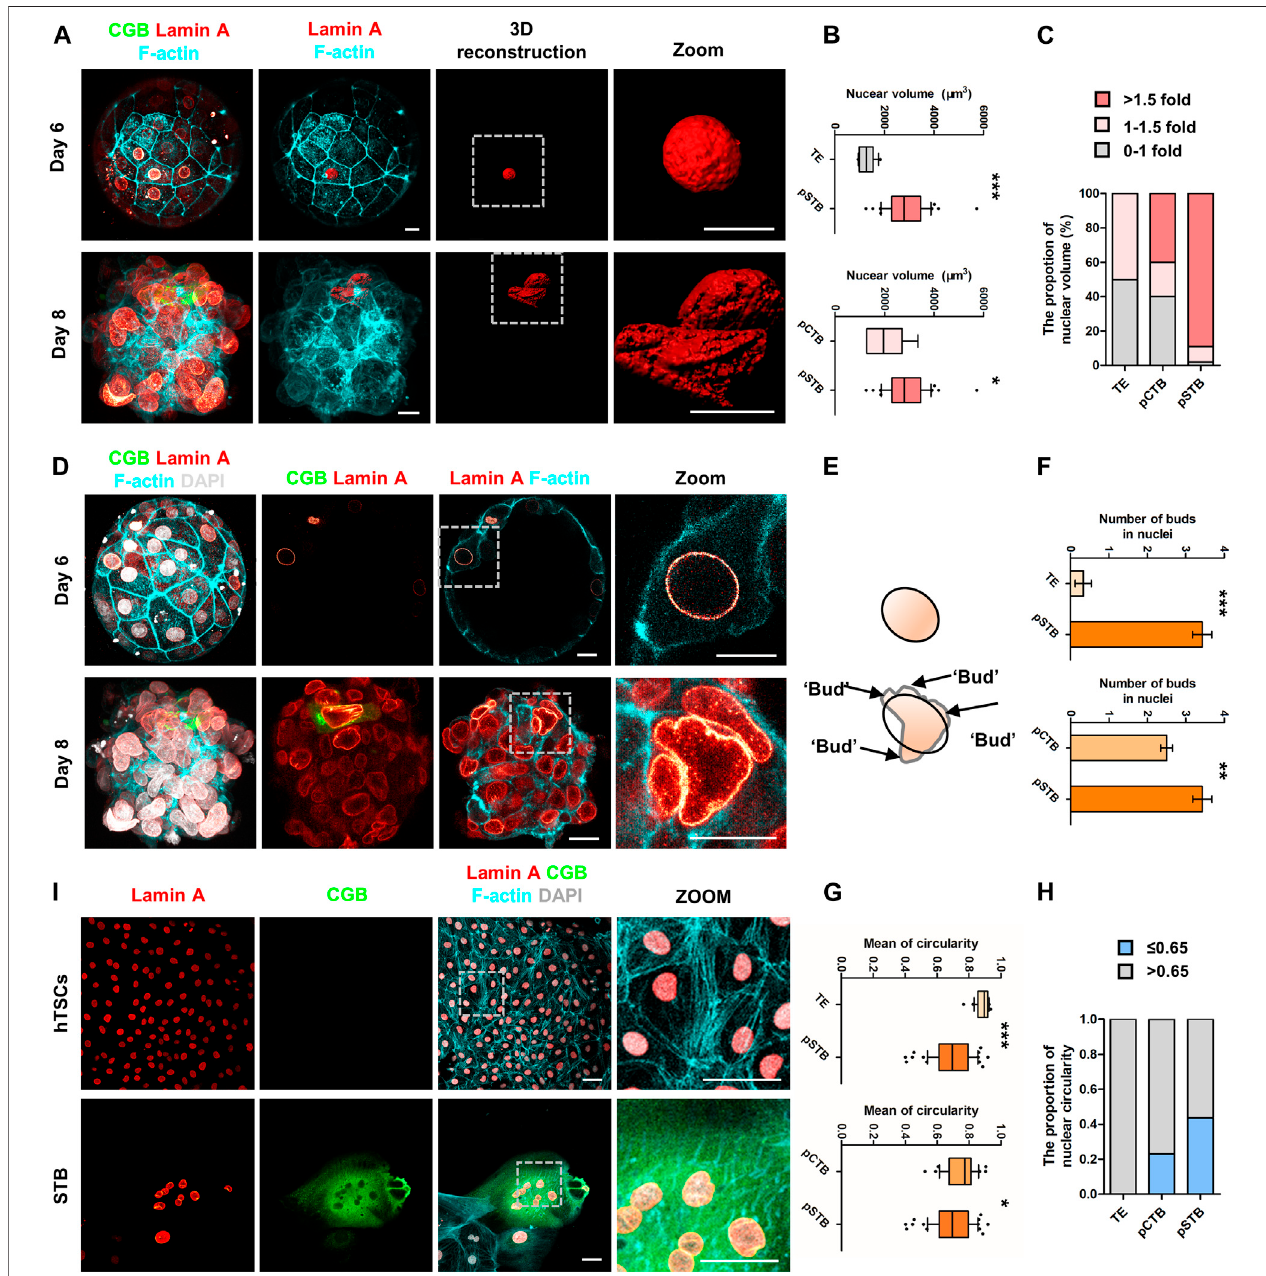
FIGURE 4 | Nuclear enlargement and deformation in primitive syncytiotrophoblast. (A) Immunostaining of day 6 and day 8 human embryos ( n = 3 and n = 3) cultured invitro forCGB,Lamin A,and F-actin.3Dreconstruction ofnucleibasingonthe immunostainingresults(shown inred). Dotted rectangle representedregions in the embryos that are shown with higher magni fi cation. Scale bars, 20 μ m. (B) Quanti fi cation of nuclear volume in TE, pCTB, and pSTB of human embryos. n = 3 human embryos per group. Data are shown as mean ± SEM. Unpaired two-tailed Student ’ s t -test, * p < 0.05; *** p < 0.001. (C) Bar graph showing the proportions of nuclear volume in TE, pCTB, and pSTB of human embryos. (D) Immunostaining of day 6 and day 8 human embryos ( n = 3 and n = 3) cultured in vitro for CGB, F-actin, and Lamin A. Dotted rectangle represented regions in the embryos that are shown with higher magni fi cation. DAPI, grey, DNA. Scale bars, 20 μ m. (E) Cartoons of nuclearmorphologybasedonimmunostainingresults.ProtrusionsaretheprojectingpointafterEllipticalFourierAnalysis. (F) Quanti fi cationofprotrusionnumbersin (D) . Data are shown as mean ± SEM. n = 3 human embryos per group. Unpaired two-tailed Student ’ s t -test, ** p < 0.01; *** p < 0.001. (G) Quanti fi cation of circularity in TE, pCTB,andpSTBofhumanembryos. n =3humanembryospergroup.Dataareshownasmean±SEM.Unpairedtwo-tailedStudent ’ s t -test,* p < 0.05;*** p < 0.001. (H) Bargraphshowingtheproportionsofnuclearcircularity. (I) ImmunostainingofhTSCsandSTBforLaminA,CGB,andF-actin.Dottedrectanglerepresentedregionsthat are shown with higher magni fi cation. DAPI, grey, DNA. Scale bars, 50 μ m.